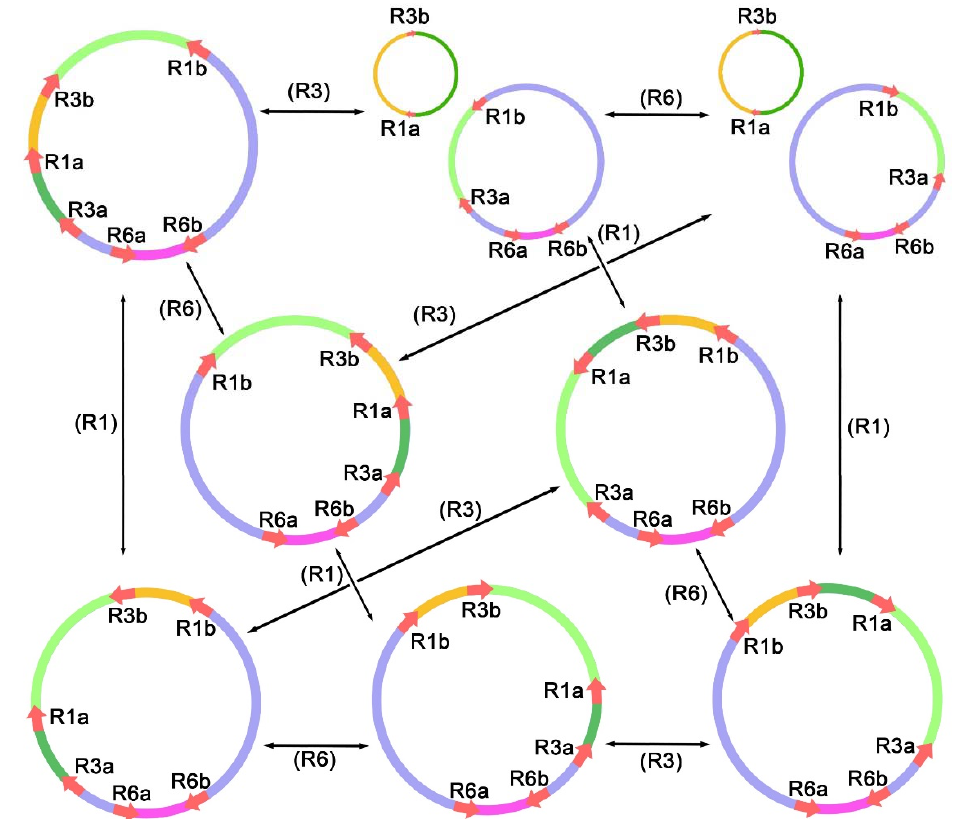
Figure 4. The possible configurations generated from intramolecular recombination mediated by repeat sequences. Here, we only describe the potential isomers generated from the three pairs of repeats with the highest recombination frequency. The three pairs of repeat sequences are R1, R3, and R6, as shown in Table 2.